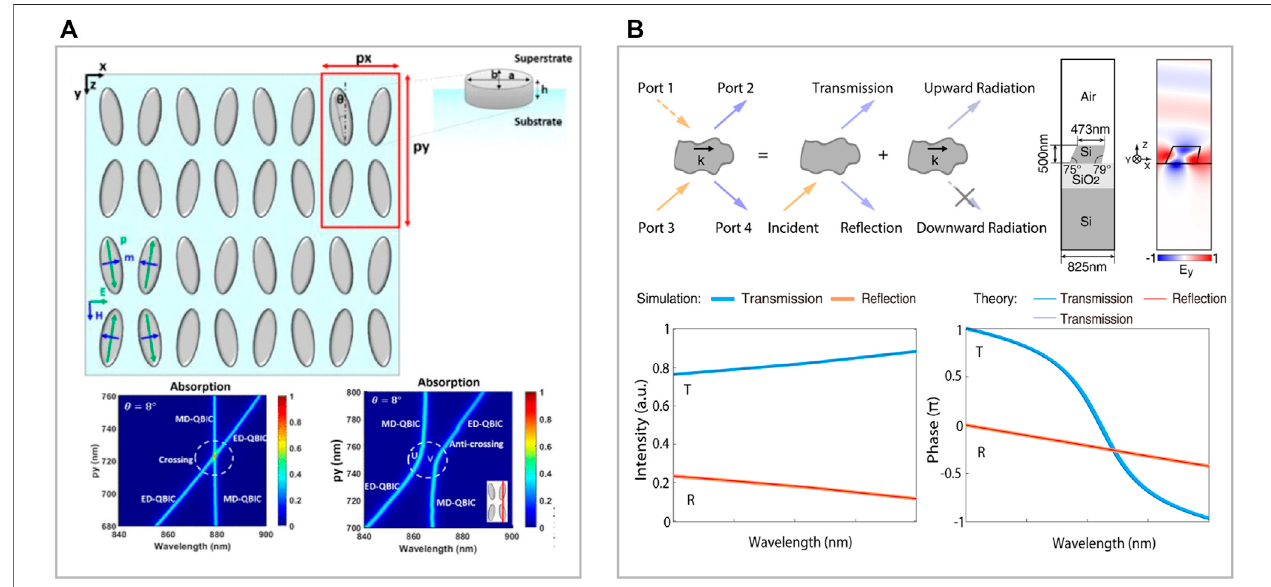
FIGURE 6 | Light manipulation in intensity and phase. (A) High- Q silicon metasurface and its absorption spectra [134], copyright American Chemical Society. (B) Intensity fl atten phase shifting based on the unidirectional radiation resonance [135], copyright De